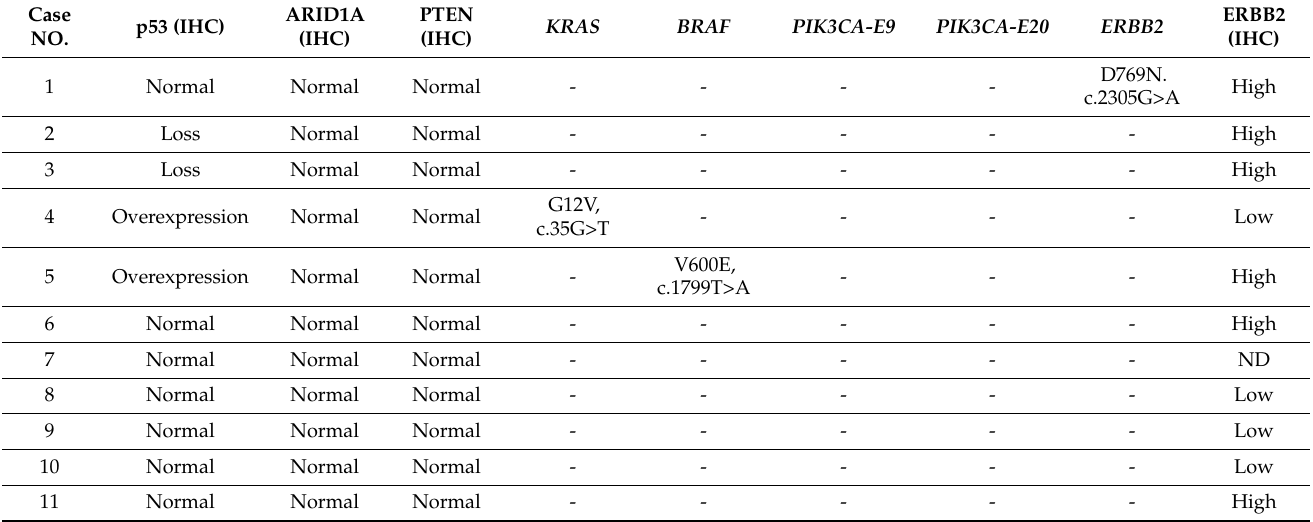
Table 2. Mutation profile of 23